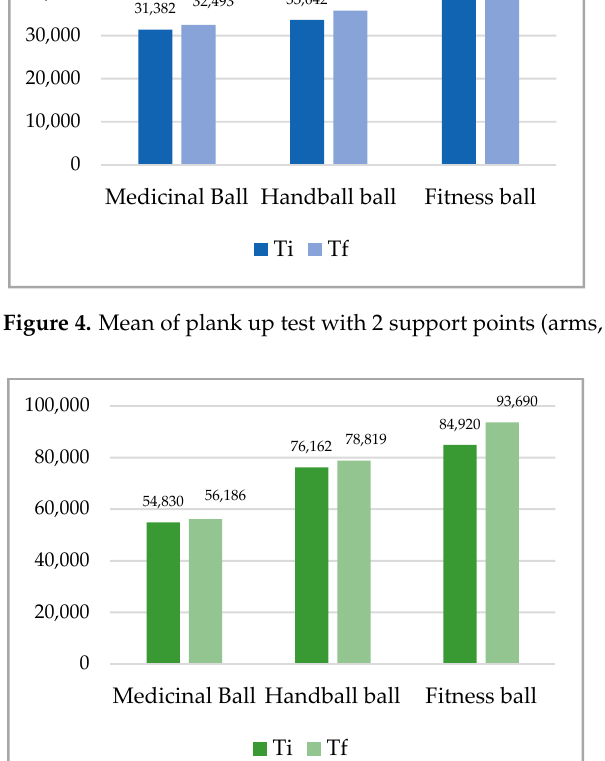
Figure 5. Mean of plank up test with 3 support points (arms, legs)—individual sports.